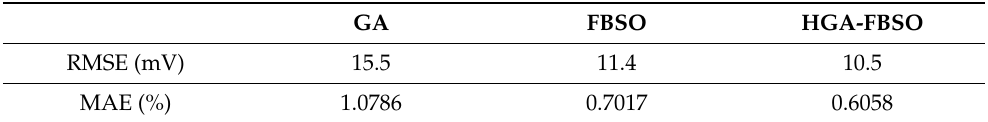
Figure 5. Output terminals voltage RE with the GA, FBSO and HGA-FBSO. Table 4. The RMSE and MAE of the battery